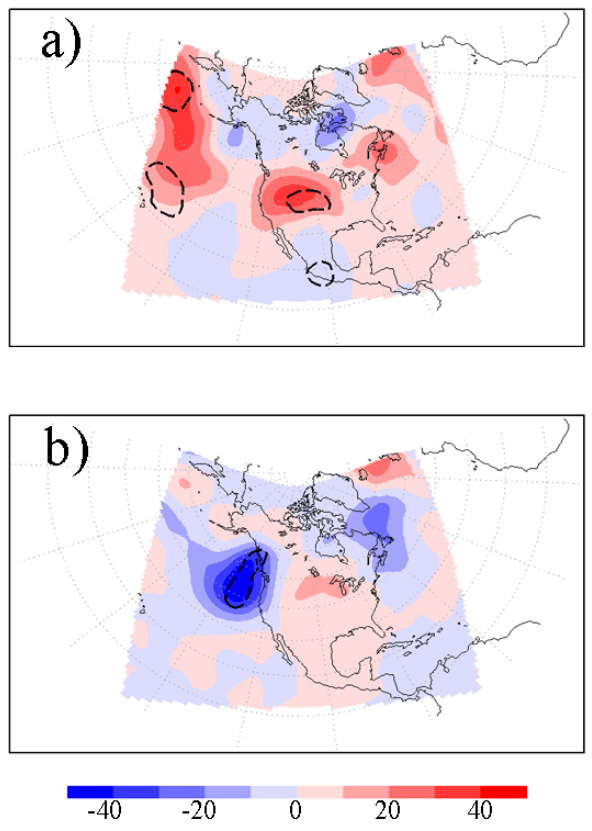
Fig. 4. Regression of 500mb geopotential height onto the time se- ries of (a) N ccn sampled at MVNP with SS = 0.3% and (b) N cn . Units are geopotential meters (gpm) per standard deviation of (a) N ccn and (b) N cn . Regions where the correlation between (a) N ccn or (b) N cn and height is significant at the 95% confidence level assuming n 0 = 23 are outlined with a dashed